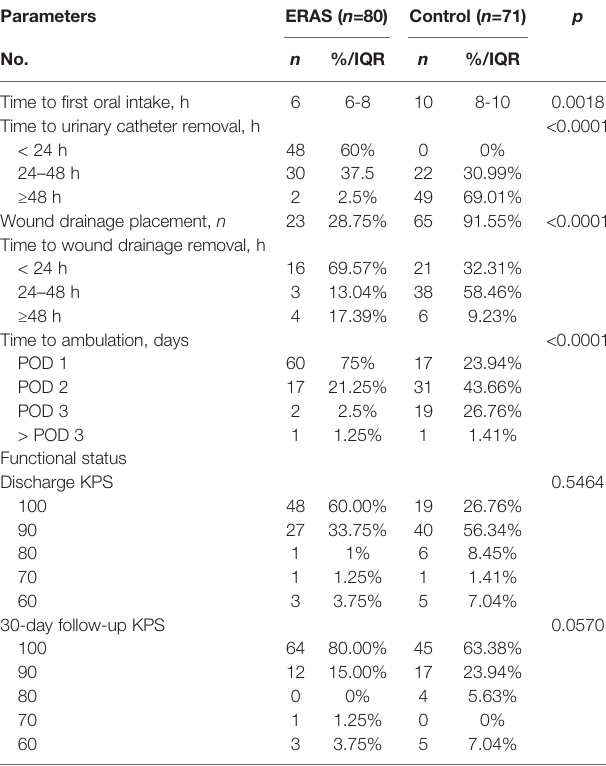
TABLE 5 | Key measures on ERAS protocol for